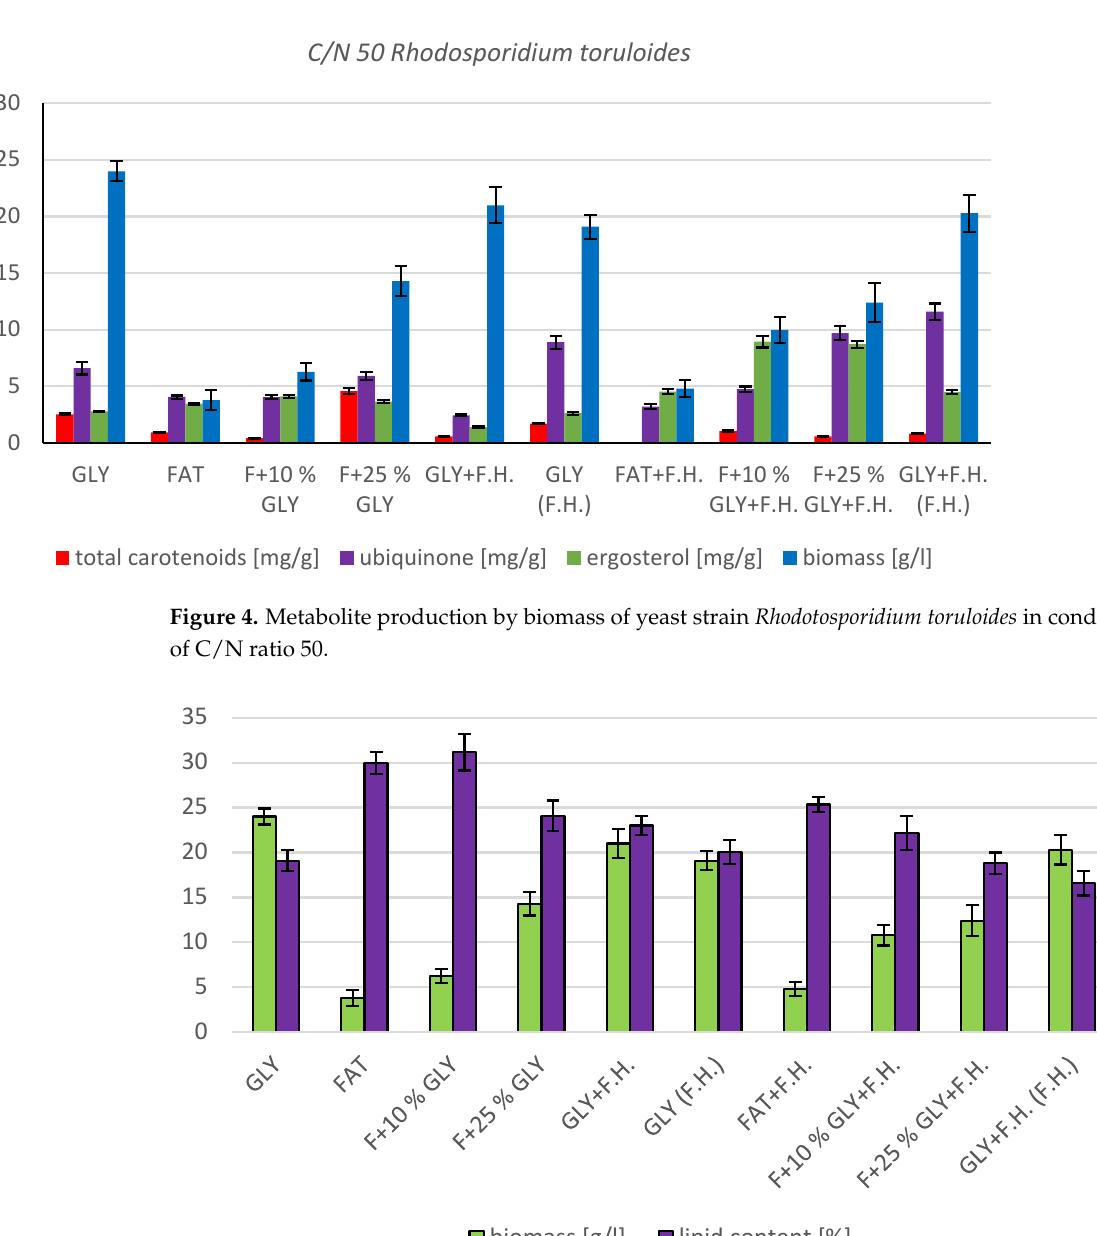
Figure 6. Fatt y acid distribution in lipids of yeast strain Rhodotosporidium toruloides in conditions of C/N ratio 50. 3.1.3. Bioreactor Cultivation of Strain Rhodotosporidium toruloides (CCY 62 - 2 - 4) The cultivation in a laboratory bioreactor showed that under controlle d conditions, a significant growth in biomass can be achieved, as can be observed in Figure 7 in the 144th hour of cultivation (34.92 g/L). The production of carotenoids did not report significant increments; its maximum was reached at the 22nd hour of cultivation (0.831 mg/g). The concentration of ergosterol in the biomass reached its maximum at the 28th hour of culti- vation (8.280 mg/g). The highest observed production of ubiquinone was at the beginning of cultivation (20.942 mg/g), but significant product ion was also achieved in the culture at the 144th hour of cultivation (12.059 mg/g). The highest percentage content of lipids in the biomass was observed at the 72nd hour of cultivation (40.81%), but the most significant production of all types of fatty ac ids was achieved at the 144th hour of cultivation (SFA 4.50 g/L, MUFA 5.15 g/L, PUFA 2.08 g/L). Results of cultivation are presented in Figures 7 –9.